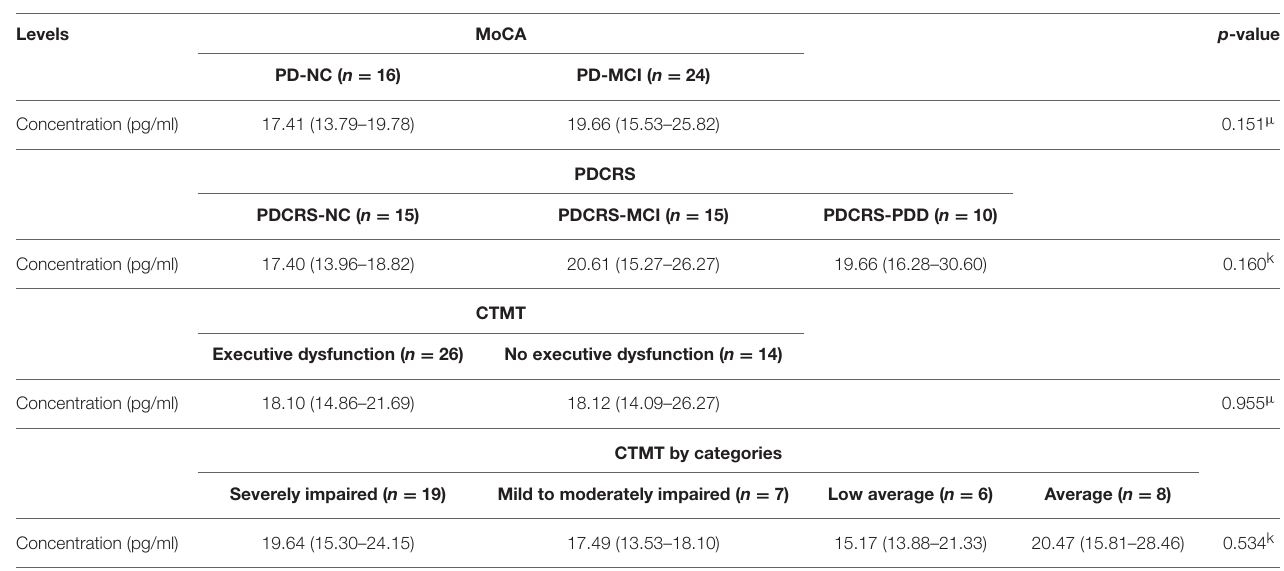
TABLE 3 | Levels of α -synuclein according to MoCA, PDCRS and CTMT ( n =